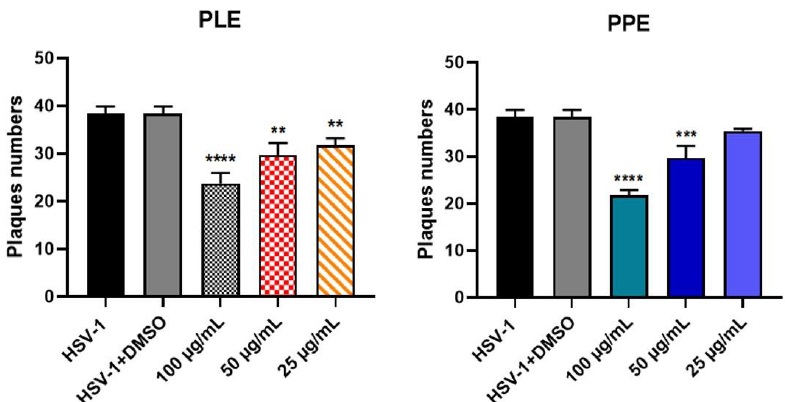
Figure 5. Plaque reduction assay. Results are the mean ± SD of triplicate experiments, and asterisks indicate a significant p -value (** p < 0.01, *** p < 0.001 and **** p < 0.0001). PLE, pomegranate leaf ethanolic extract; PPE, pomegranate peel ethanolic extract. Table 3. Selectivity index (SI), cytotoxicity (CC 50 ), and antiviral activity (EC 50 ) of PLE and